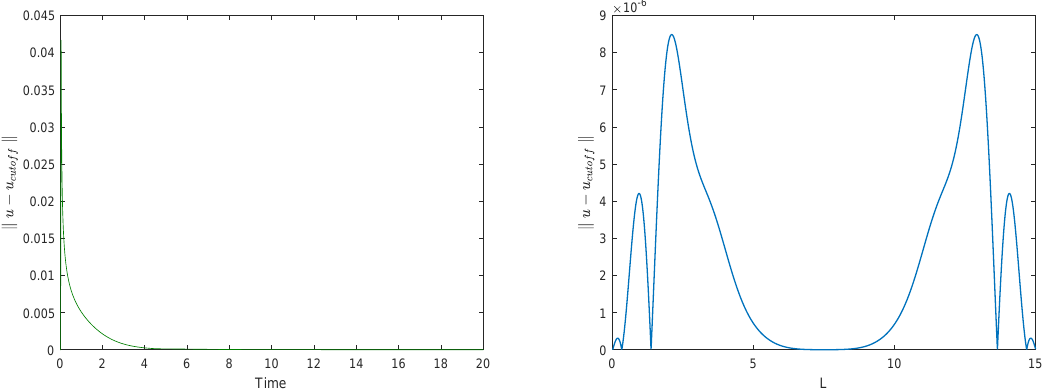
Figure 6. ( left ) maximum error as a function of time; ( right ) distribution of error (cid:107) u − u cutof f (cid:107) over the domain 0 < x < L at t =